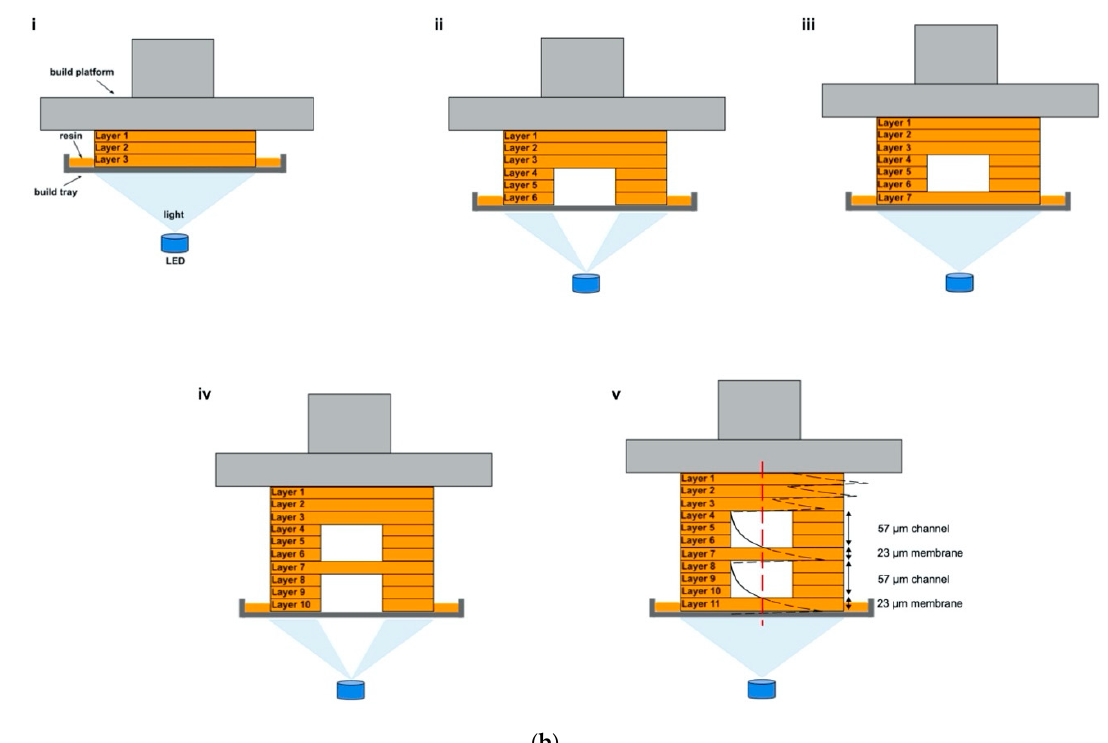
Figure 3. ( a ) Dose curve simulating 57 µ m channels (designed with 60 µ m) with 23 µ m membranes (designed with 20 µ m). Exposed layers are shaded grey; ( b ) schematic demonstrating corresponding curing pattern to the dose curve simulation where (i) corresponds to the first 3 layers of the pattern from ( a ), (ii) is the next three layers forming the first channel, (iii) layer 7 is the 23 µ m membrane closing off the first channel, (iv) is the next three layers forming the second channel, (v) layer 11 closes off the second channel with a 23 µ m membrane. The total normalized dose curve from ( a ) is overlaid on (v) after rotating 90 degrees. The vertical dashed line (red) indicates the region over which the dose curve was calculated. The Schematic is not to scale.